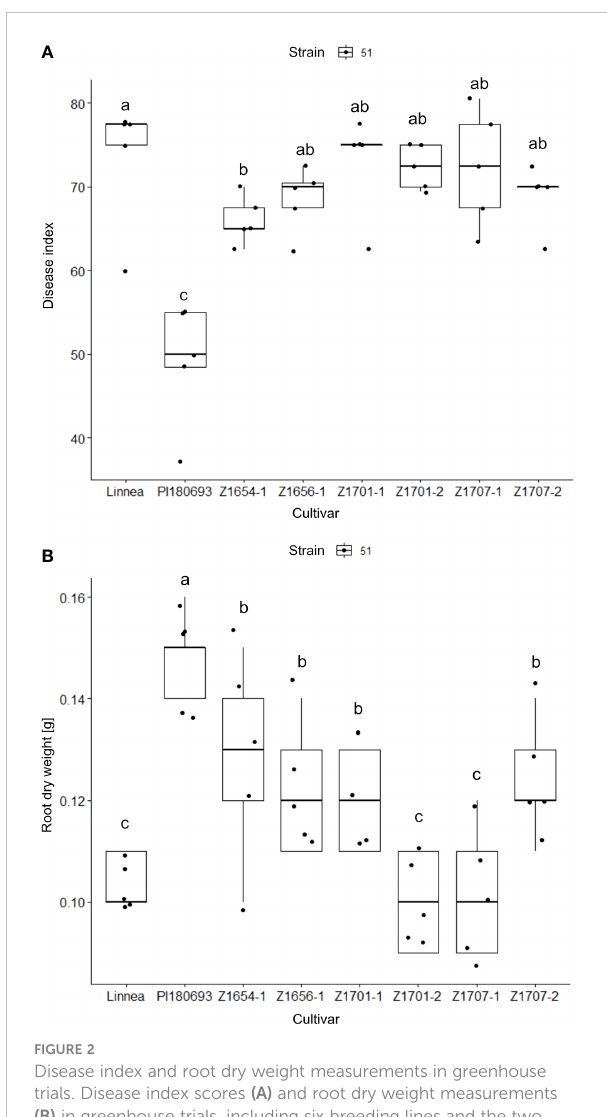
FIGURE 2 Disease index and root dry weight measurements in greenhouse trials. Disease index scores (A) and root dry weight measurements (B) in greenhouse trials, including six breeding lines and the two parental lines, upon infection with A. euteiches strain SE51 with intermediate virulence Disease index scores (0 = completely healthy plant, 100 = completely diseased) and root dry weight measurements [g] are averages of fi ve biological replicates. Letters a-c indicate Fisher ’ s signi fi cant ( p > 0.05) differences between means of disease indexes and root dry weight between